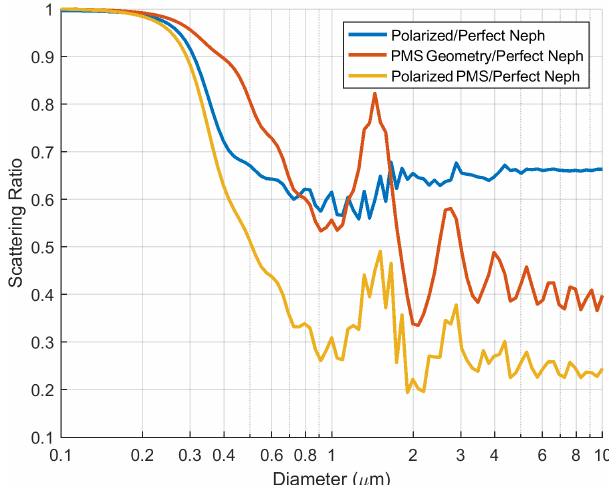
Figure 7. Ratio of scattering of a “perfect” nephelometer to a neph- elometer with a light source that is perpendicularly polarized (blue) and to a PMS with an unpolarized light source (red). The yellow line shows the effect of a perpendicularly polarized light source and PMS geometry. All three curves are plotted as a function of particle diameter.